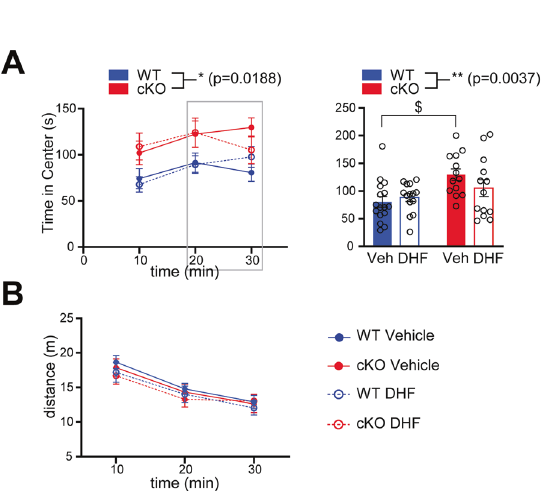
Fig. 7 BDNF signaling only partially contributes to the anxiety- like phenotype of Kidins220 cKO mice. A WT and cKO mice that received DHF or vehicle in the drinking water for 4 weeks were tested in the open fi eld test. The experiment was performed and quanti fi ed as in Fig. 5A. Left: cKO mice spent more time in the center of the arena, con fi rming the reduced anxiety phenotype ( F 3,53 = 3.623; * p < 0.05 genotype effect, RM-ANOVA). Right: the bar graph shows the time spent in the center by the four experimental groups in the last 10 min of the test. Vehicle-treated cKO mice spent signi fi cantly more time in the center compared to WT animals ( F 1,52 = 9.250; ** p < 0.01 genotype effect, $ p < 0.05 two-way ANOVA/ Holm- Š ídák ’ s multiple comparisons test), while no difference was detected between the DHF-treated groups. B The distance traveled was comparable across genotypes ( F 3,51 = 0.2802; p > 0.05 genotype effect, RM-ANOVA). WT Vehicle n = 16; WT DHF n = 15; cKO Vehicle n = 13; cKO DHF n = 13. In all panels, values are plotted as mean ± S.E.M, and individual values are represented with circles.